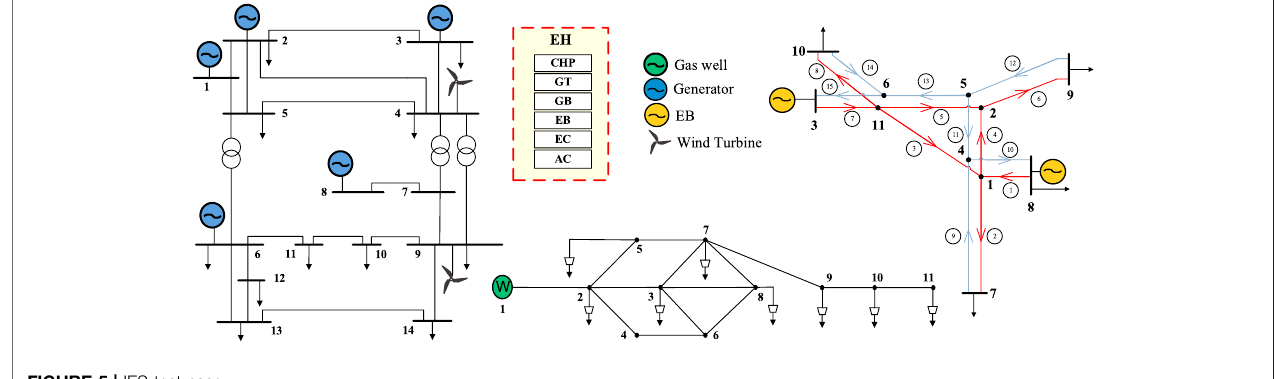
FIGURE 5 | IES test case.